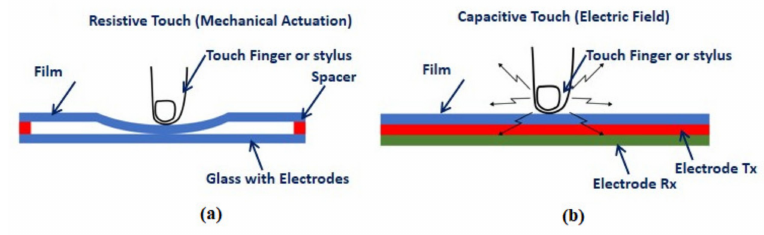
Figure 1. Working mechanism of touch panel sensors ( a ) Resistive ( b )